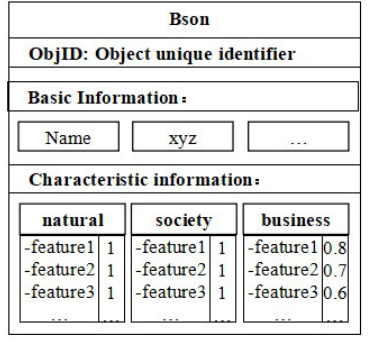
Figure 4 Geographic feature information model structure